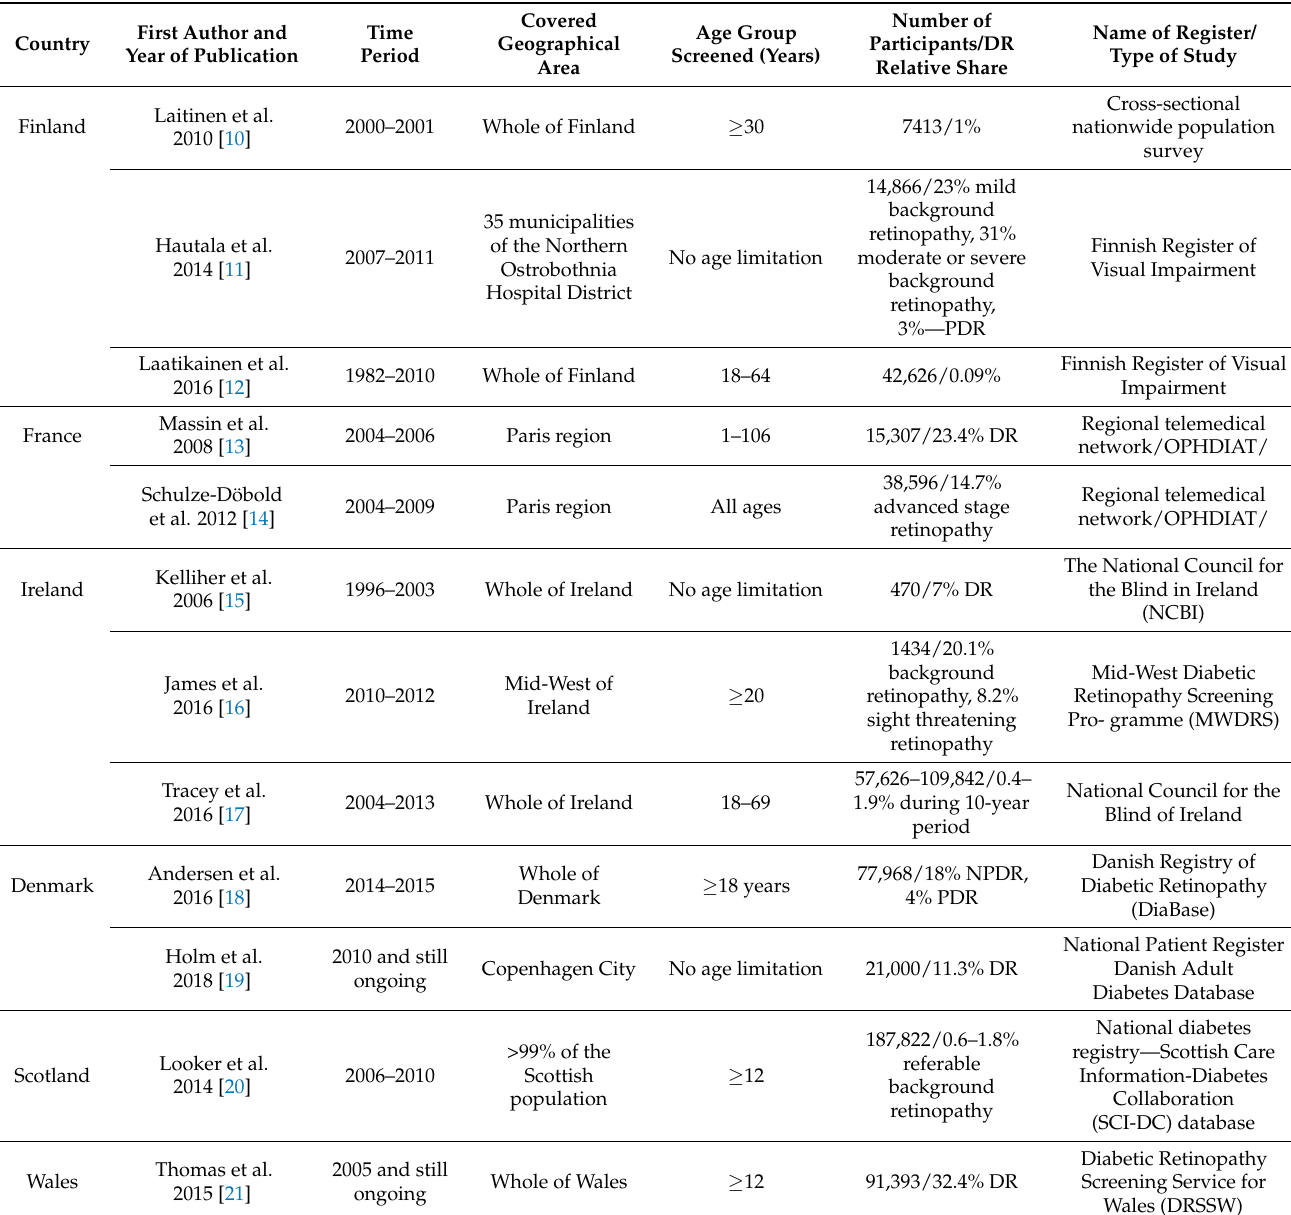
Table 1. Summary characteristics of the included